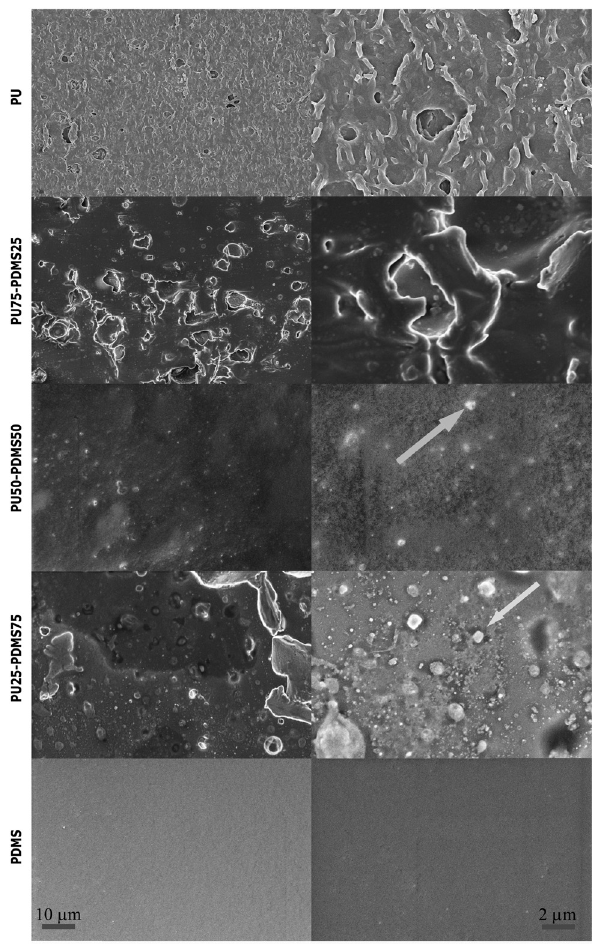
Figure 6: The surface views of AISI 316L coated with PU – PDMS polymers.